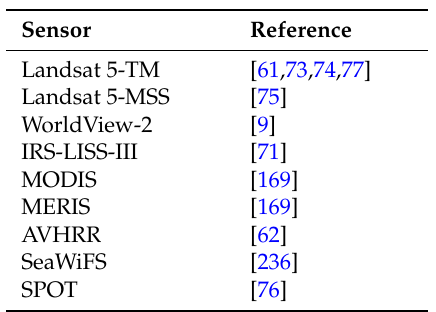
Table 12. Remote sensing of dissolved oxygen (DO), biochemical oxygen demand (BOD), and chemical oxygen demand (COD) based on the used